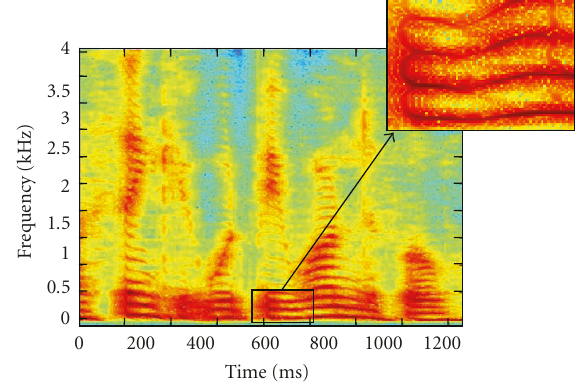
Figure 1: Illustration of the region D